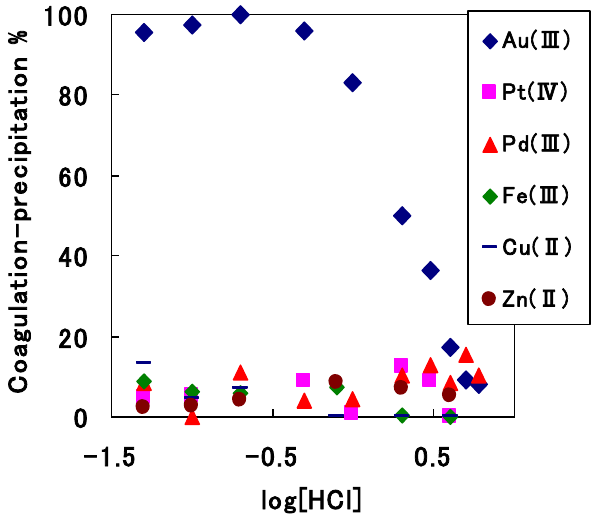
Figure 16. Percentage recovery of various metal ions by means of coagulation using persimmon extract liquor from varying concentration (mol·dm −3 ) of hydrochloric acid solution [32] (with permission for reuse from The Society of Chemical Engineers of